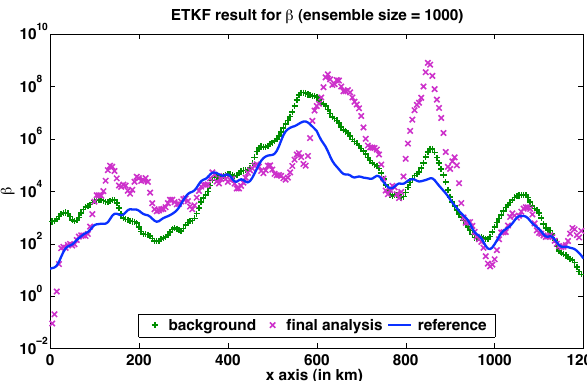
Fig. 8. Ice sheet geometries after 20years, with the 1000-member ETKF. The analysis bedrock topography (final mean ensemble in purple x) is compared to the background (green crosses) and the ref- erence (blue). The analysis result and the reference are really close except for around 150km from the origin (see also Fig. 9 for de- tailed results). The surface elevation is accurately observed (in red), so that background, reference and analysis are similar.